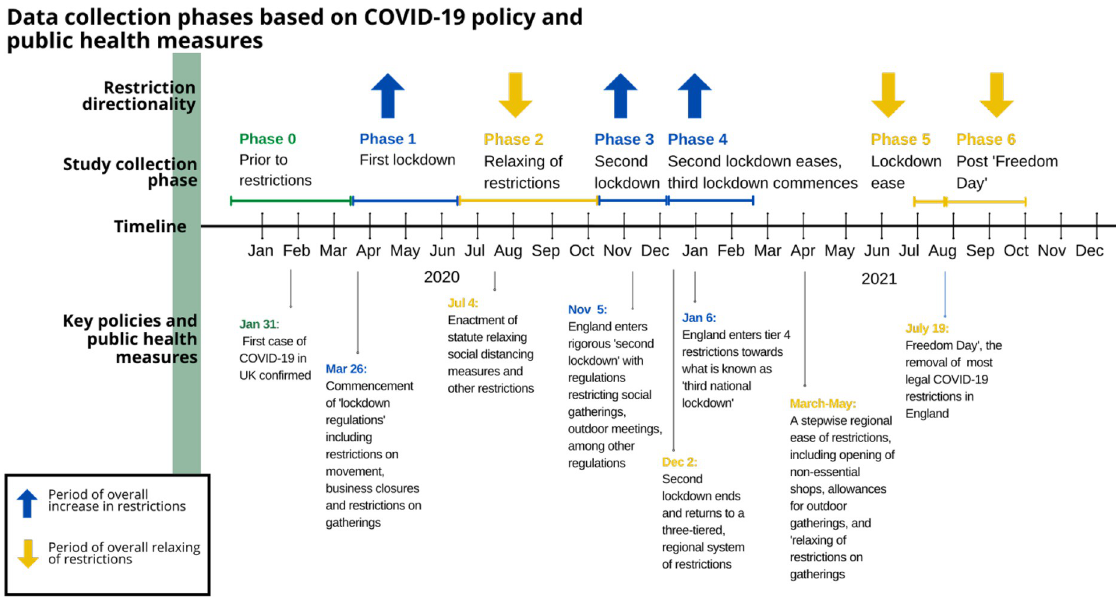
Fig 1. Data collection phases based on COVID-19 policy and public health measures. https://doi.org/10.1371/journal.pone.0270207.g001 measures 16 activity types using categories defined by the UK National Time Use Survey [27]. The activities included in the survey are listed in Table 1. Participants were asked two ques- tions for each of the 16 activities; the frequency they performed the activity and mode of access.